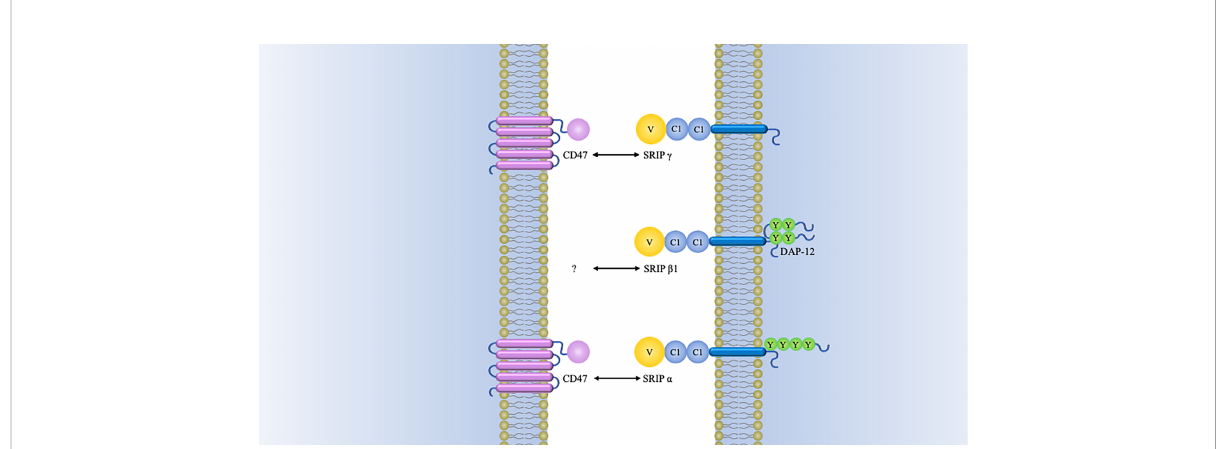
FIGURE 2 Schematics of structure of SIRP family members. Besides SIRP a , SIRP b 1, and SIRP g have also been identi fi ed in humans. Both of SIRP b 1 and SIRP g consist of three Ig-like loops in their extracellular domains. SIRP b 1 is characterized by a basic amino acid side chain in its transmembrane domain with a very short cytoplasmic region. This transmembrane region is indispensable for binding of DAP12 (DNAX activation protein 12). It has been established that SIRP b 1 can mobilize the tyrosine kinase Syk, which was followed by MAPK (mitogen-activated protein kinase) activation and microglial phagocytosis enhancement (26). However, it remains unknown what the extracellular ligand for SIRP b 1 and how it might regulate cellular function. There is also a short cytoplasmic region in SIRP g , but it is quite different from SIRP b 1. The former lacks a charged amino acid residue in its transmembrane region. Nevertheless, SIRP g can still interact with CD47 by the way of protein-protein binding studies (27). One study has demonstrated that endothelial cell CD47 interacting with SIRP g plays an important role in T-cell trans-endothelial migration (28). SIRP b 2 is expressed by cells of the monocyte-macrophage lineage and presumably has an association with DAP12 or a similar adaptor (14). SIRP d has only one domain and has not yet been found any obvious means of membrane attachment